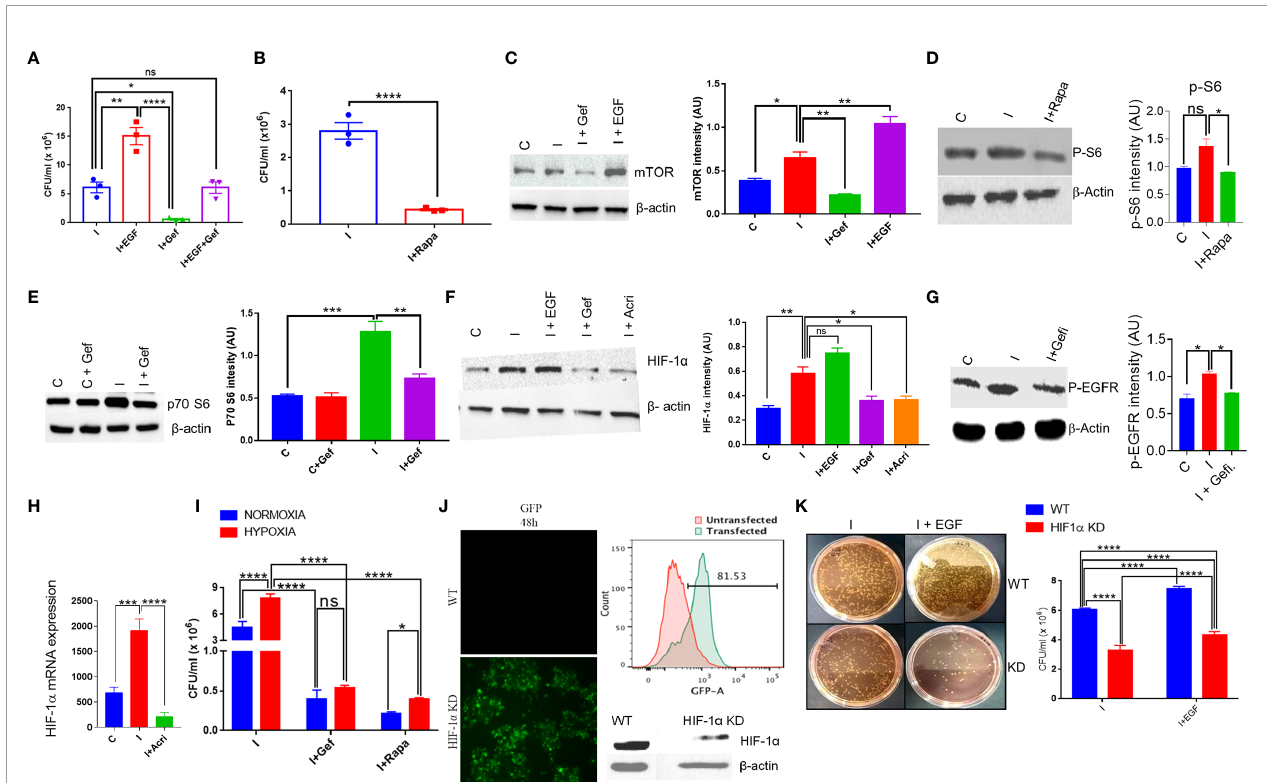
FIGURE 3 | S. typhi exploits mTOR-HIF-1 a axis to promote its own survival. (A) Colony-forming assay in the presence of an EGFR agonist or reverse agonist was performed for S . typhi infection in THP-1 cells. A similar assay was performed in the presence of Rapamycin, (B) . CFU in presence of Rapamycin. (C – G) . Protein expression of mTOR, p70-S6, HIF-1 a and p-EGFR in THP-1 cells was determined by western blotting and quantitated by using ImageJ software in the presence or absence of infection and treatments (Panel C-G ). (H) q-PCR for mRNA expression of HIF-1 a in THP-1 cells with or without infection,. (I) Intracellular survival of S. typhi inside THP-1 cells under normoxia or hypoxia condition. HIF-1 a guided RNA tagged with GFP was used to knock out the HIF-1 a gene in THP-1 cells. Confocal microscopy images acquired 48 h after HIF-1 a knockout showing high GFP expression in knockout THP-1 cells ( J left panel), which was further con fi rmed by fl ow cytometry showing histogram overlay ( J upper right panel); data represent two independent experiments. Western blot ( J lower right panel) showing low expression of HIF-1 a . (K) Intracellular survival of S. typhi in WT or HIF-1 a knockout cells. Data are representative of mean ± SEM from three replicates and repeated three times each individual experiments *P < 0.05, **P < 0.01, ***P < 0.001, ****P < 0.0001 (Student ’ s t-test and one way